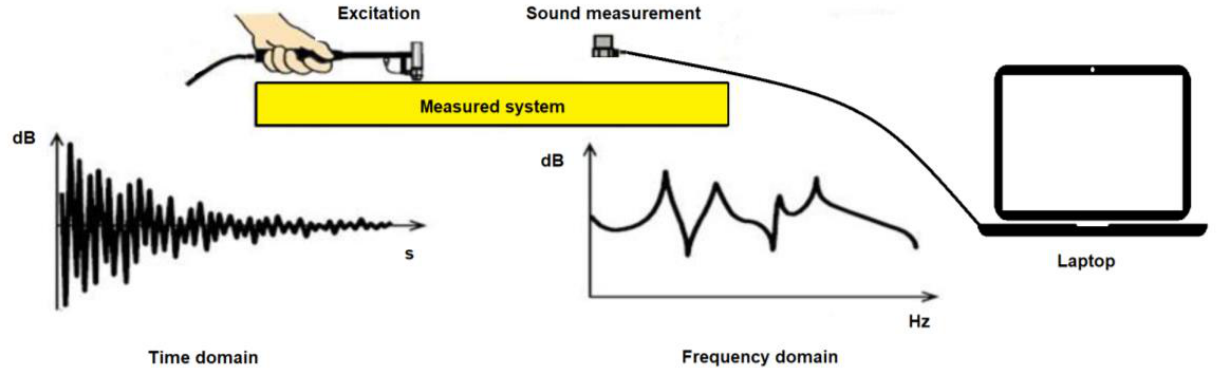
Figure 2. Sound measurements and analysis — response to vibrations generated by impact hammer.